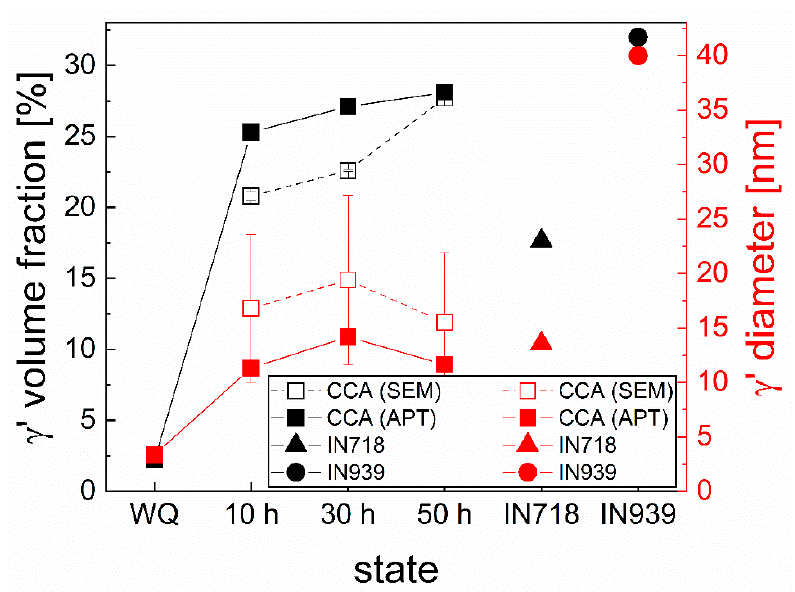
Figure 4. Volume fraction and size of the γ ’ precipitates in WQ and aged states (all after homogenization and annealing) from SEM and APT measurements compared to literature data for the Ni-based alloys IN718 and IN939